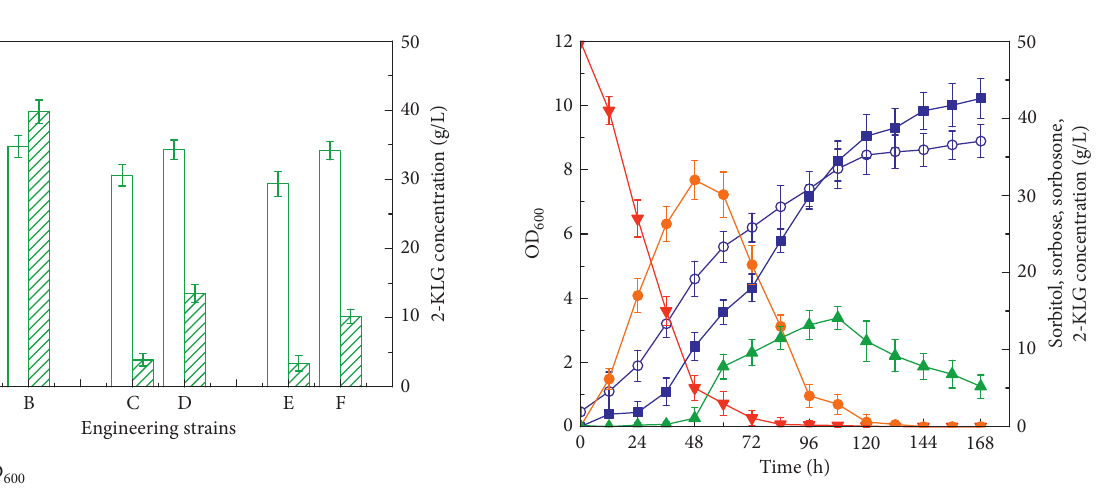
Figure 7: Time course of oxidative fermentation of D-sorbitol by the PQQ biosynthesis enhanced engineered strains. The symbols ▼ , ● , ▲ , Figure 5: Production of 2-KLG by CutA-based engineered strain and ■ represent the concentration of D-sorbitol, L-sorbose, L-sor- and the control strain at different temperatures. A, C, and E are bosone, and 2-KLG produced by G. oxydans /pGUC- tufB - SH3 - sdh - OD 600 and 2-KLG production of G. oxydans /pGUC- tufB - sdh - GGGGS- sndh - tufB - SH3 lig -(GGGGS) 2 - cutA - tufB - pqq ABCDE, respec- GGGGS- sndh at 30 ° C, 35 ° C, and 37 ° C, respectively. B, D, and F are tively. The symbol ○ represents OD 600 of G. oxydans /pGUC- tufB - SH3 - OD 600 and 2-KLG production of G. oxydans /pGUC- tufB - SH3 - sdh - sdh -GGGGS- sndh - tufB - SH3 lig -(GGGGS) 2 - cutA - tufB - pqq ABCDE, re- GGGGS- sndh - tufB - SH3 lig -(GGGGS) 2 - cutA at 30 ° C, 35 ° C, and spectively. Error bars represent the standard deviation of three bio- 37 ° C, respectively. Error bars represent the standard deviation of logical three biological replicates. the wild-type strain. Furthermore, overexpression of PQQ pGUC- tufB - SH3 - sdh -GGGGS- sndh - tufB - SH3 -(GGGGS) - lig 2 biosynthesis genes significantly enhanced cell growth, and the cutA - tufB - pqq ABCDE after 168 h of fermentation is sum- likely reason for this is that PQQ is also a signaling molecule marized in Figure 7. Overexpression of pqq ABCDE gene in signal transduction pathways that affect bacterial growth by clusters enhanced PQQ production by 262.5% compared with